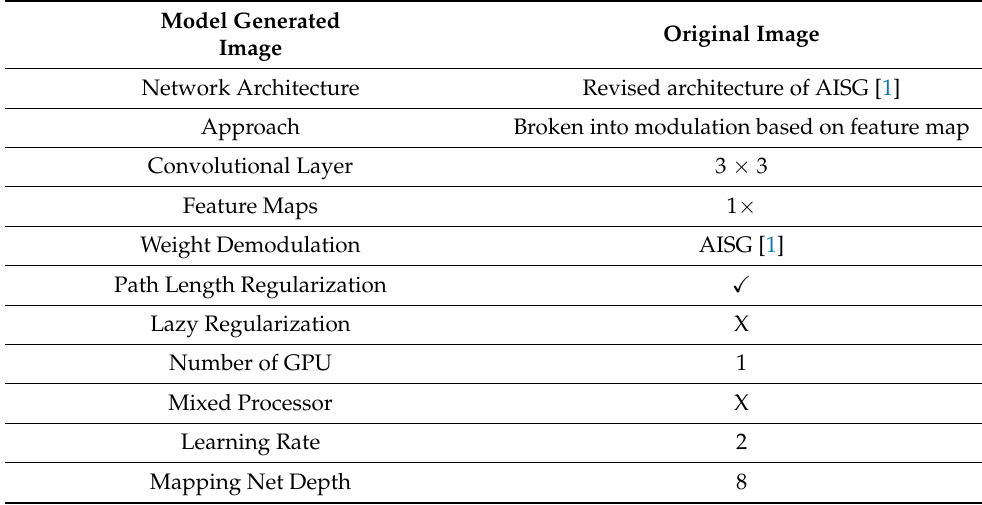
Table 9. The Proposed